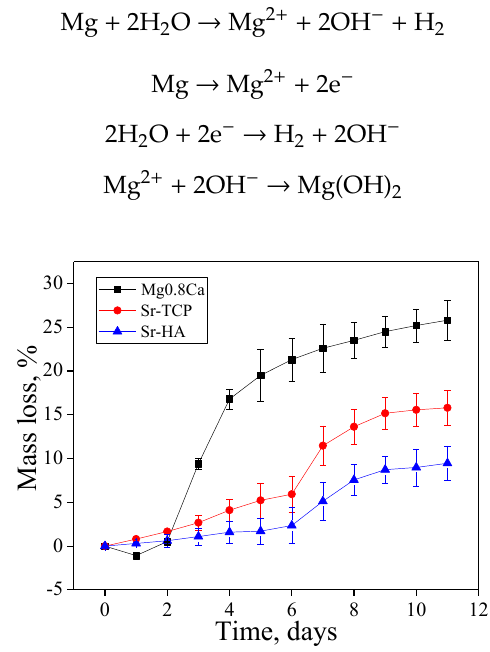
Figure 9. Graphs of the mass loss over time.